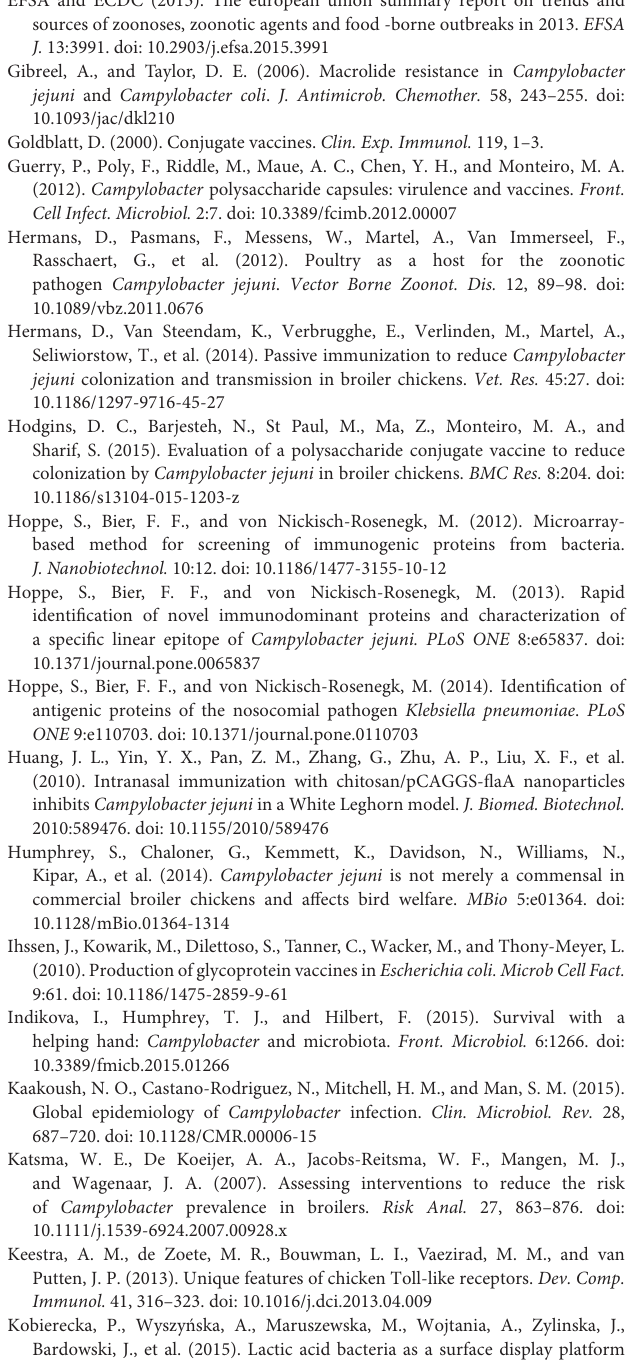
FIGURE S2 | Western blot analysis of the specificity of 6xHis-rCjaAD-LysM. Proteins were separated by 12% SDS-PAGE under reducing conditions and probed with: (A) anti-LysM, (B) anti-CjaA, and (C) anti-CjaD antibodies. Lanes: 1 – purified protein 6xHis-rCjaAD-LysM, M – protein molecular-weight marker.